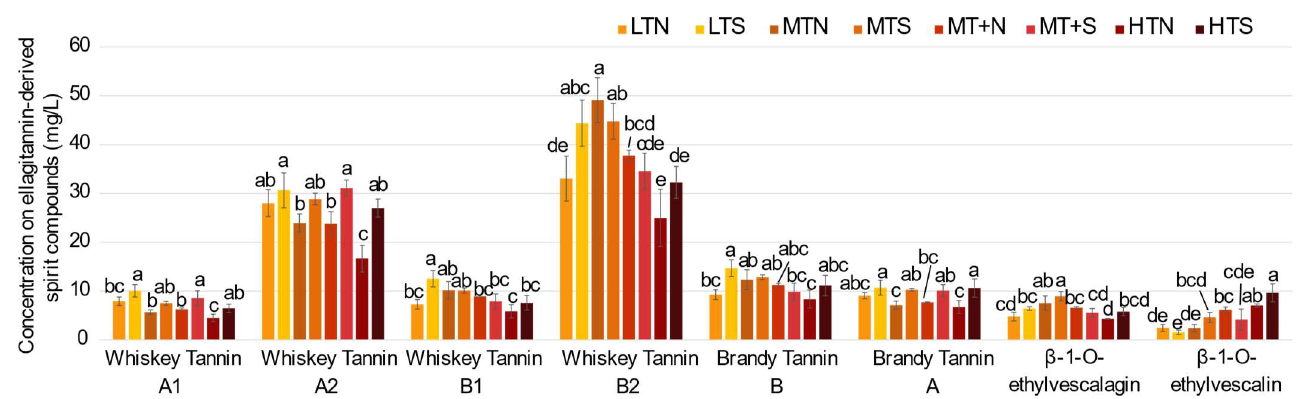
Figure 6. Impact of barrel toasting (LT: Light Toasting; MT: Medium Toasting; MT+: Medium Toasting Plus; HT: High Toasting; N: Normal; S: Slow) on concentrations of the ellagitannin-derived spirit compounds ( 9 – 16 ) in eau-de-vie at 18 months of aging. Error bar represents the confidence interval with a threshold of 0.05. Lower case letters a–e show significant differences among the different toasting modalities for each ellagitannin-derived spirit compound ( p < 0.05).